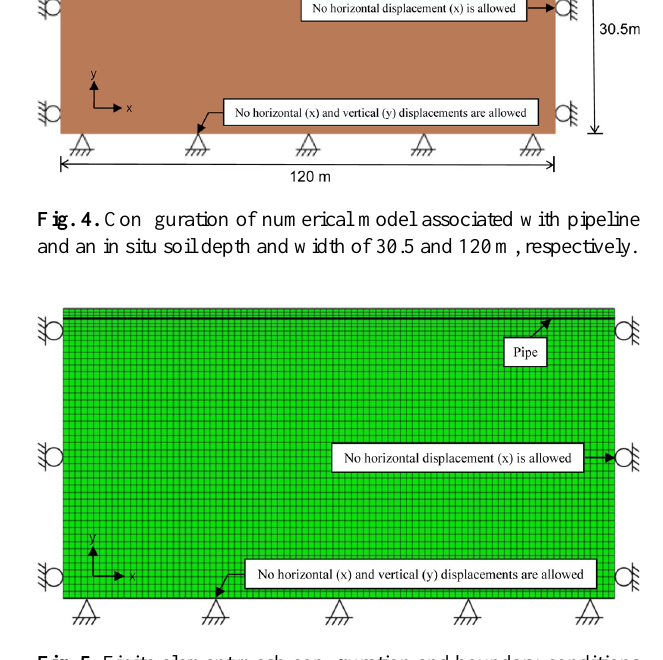
Fig. 5. Finite element mesh configuration and boundary conditions for pipelines and an in situ soil depth and width of 30.5 and 120m,